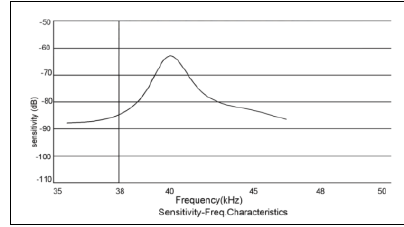
Fig. 4. Frequency characteristics for transmitters/ receivers MCUST/R.